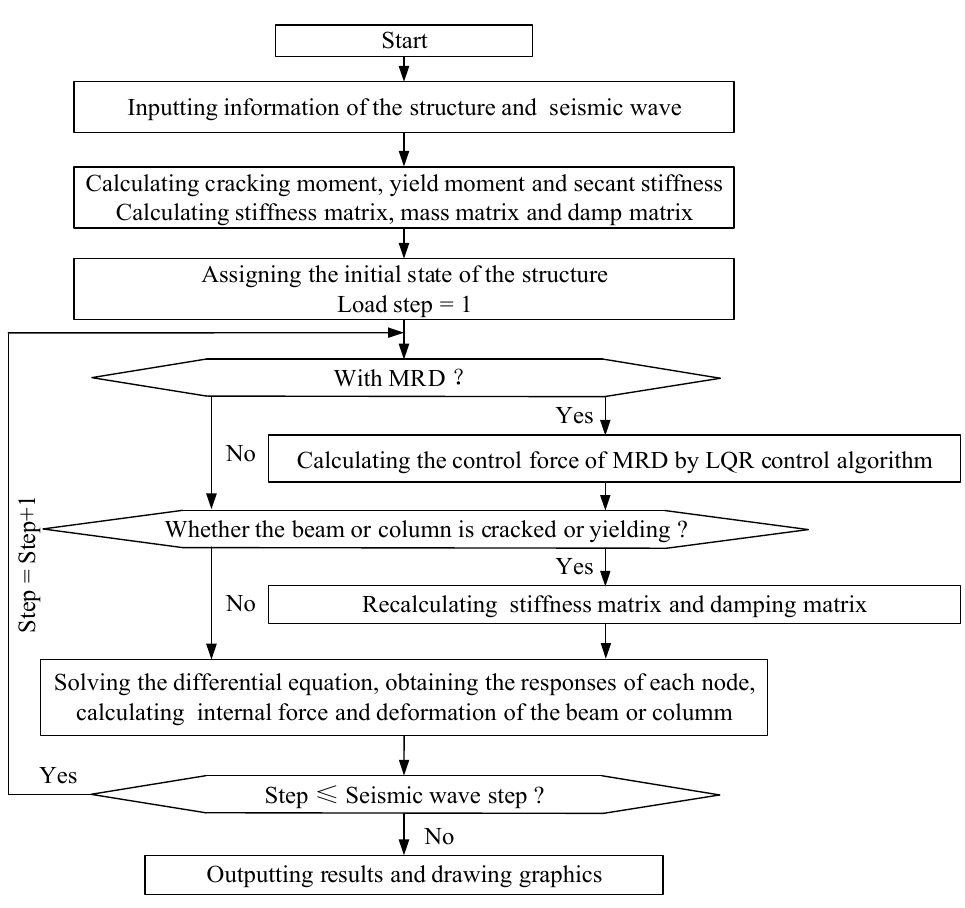
Figure 8. Calculation flowchart of elastic–plastic time history analysis program.